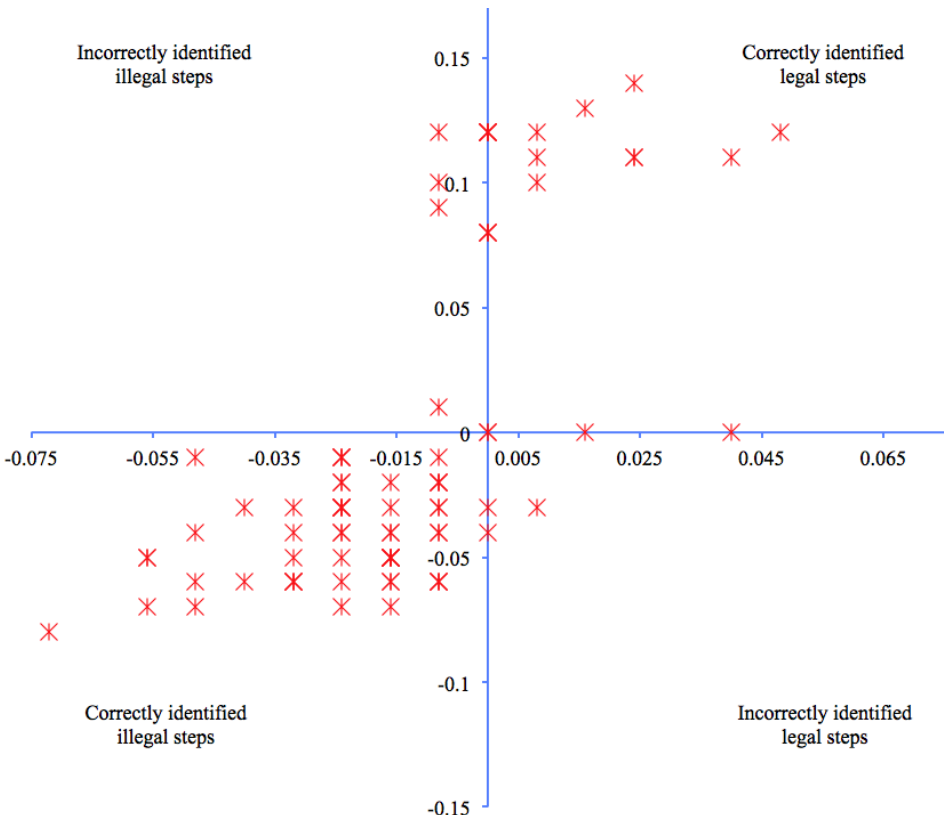
Figure 3. Inertial sensor and high-speed camera comparison of legal and illegal steps. X axis represents step timings captured by the high-speed camera. Y axis depicts inertial sensor step timings. Positive data from either system indicate legal steps. Negative data represents illegal steps. Therefore the top right and bottom left quadrants show inertial sensor data in agreement with high-speed camera data for respective legal and illegal steps. The top left quadrant indicates illegal steps identified in the camera data and not detected by the sensors. The bottom right quadrant depicts steps in the camera data that were shown to be legal and deemed illegal in the inertial sensor data. Markers that are slightly darker than other data indicate multiple gait events occurring at that point in the